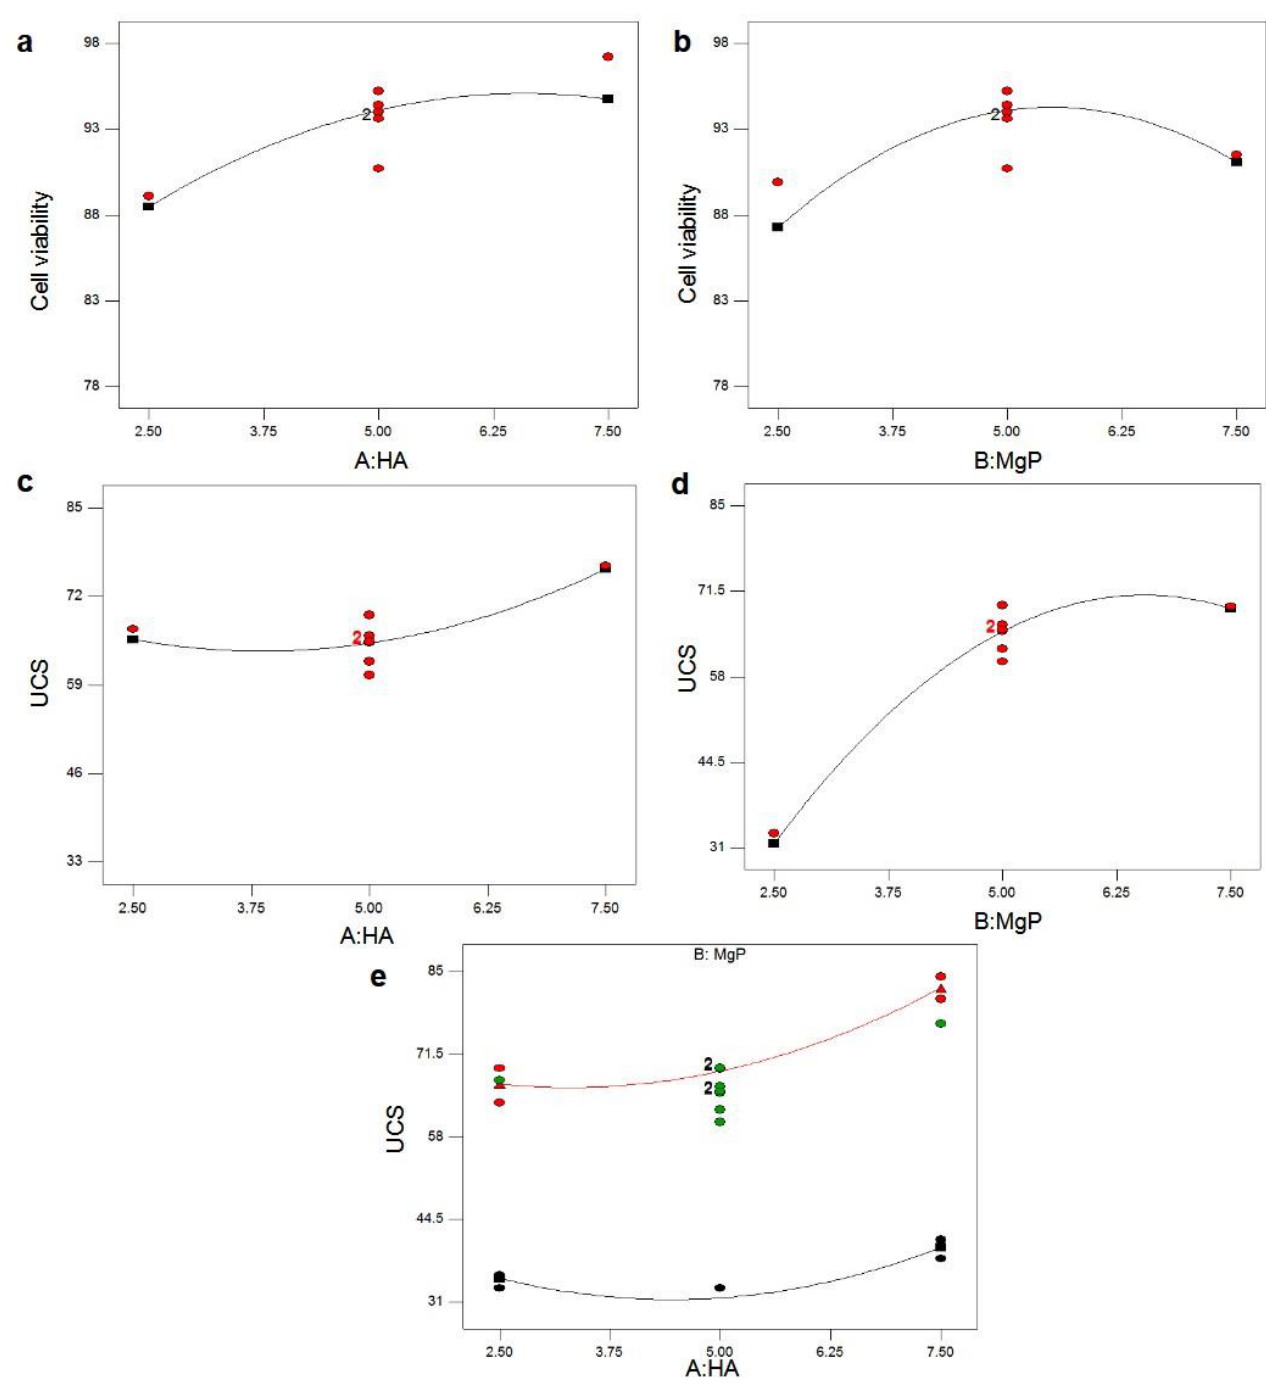
Figure 5. ( a , b ) The main effect plot for cell viability and ( c , d , e ) the main effect plot and interaction plot for UCS.